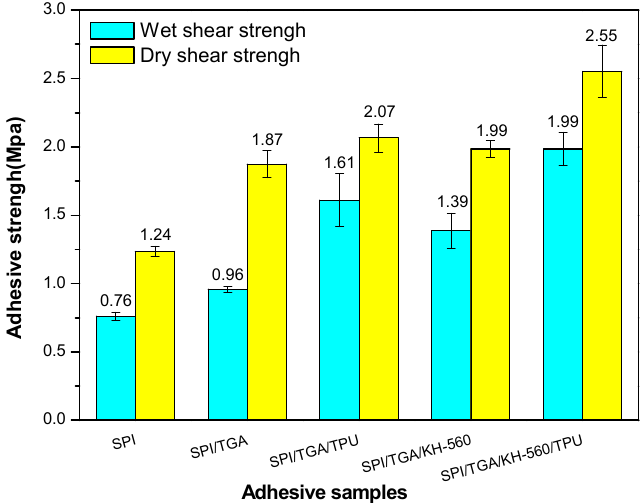
Figure 9. Dry and wet shear strength of the plywood of the cured adhesive.